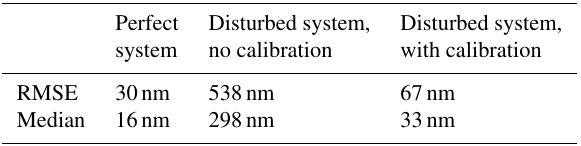
Table 1. Root mean squared error and the median of absolute er- rors for the predictions of the same U-Net using different inputs. The perfect TWI system, which was also used to generate the train- ing data, is in the first column, the disturbed TWI system without calibration is in the second column, and the hybrid method is in the third